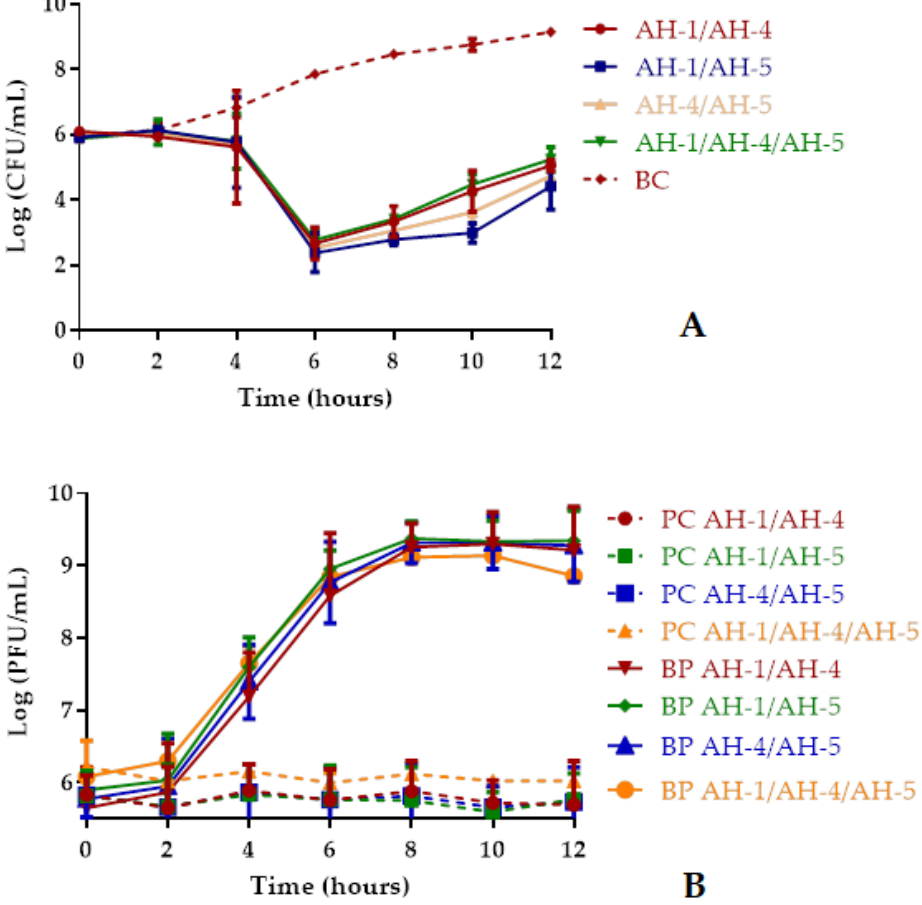
Figure 4. Inactivation of A. hydrophila by phage cocktails (AH-1/AH-4, AH-1/AH-5, AH-4/AH-5, and AH-1/AH-4/AH-5) at an MOI of 1 during 12 h. ( A ) Bacterial concentration: BC, bacteria control; BP, bacteria plus phage. ( B ) Phage concentration: PC, phage control; BP, bacteria plus phage. AH-1, phage AH-1; AH-4, phage AH-4; and AH-5, phage AH-5. Values represent the mean of the three experiments, and the error bars represent the standard deviation.